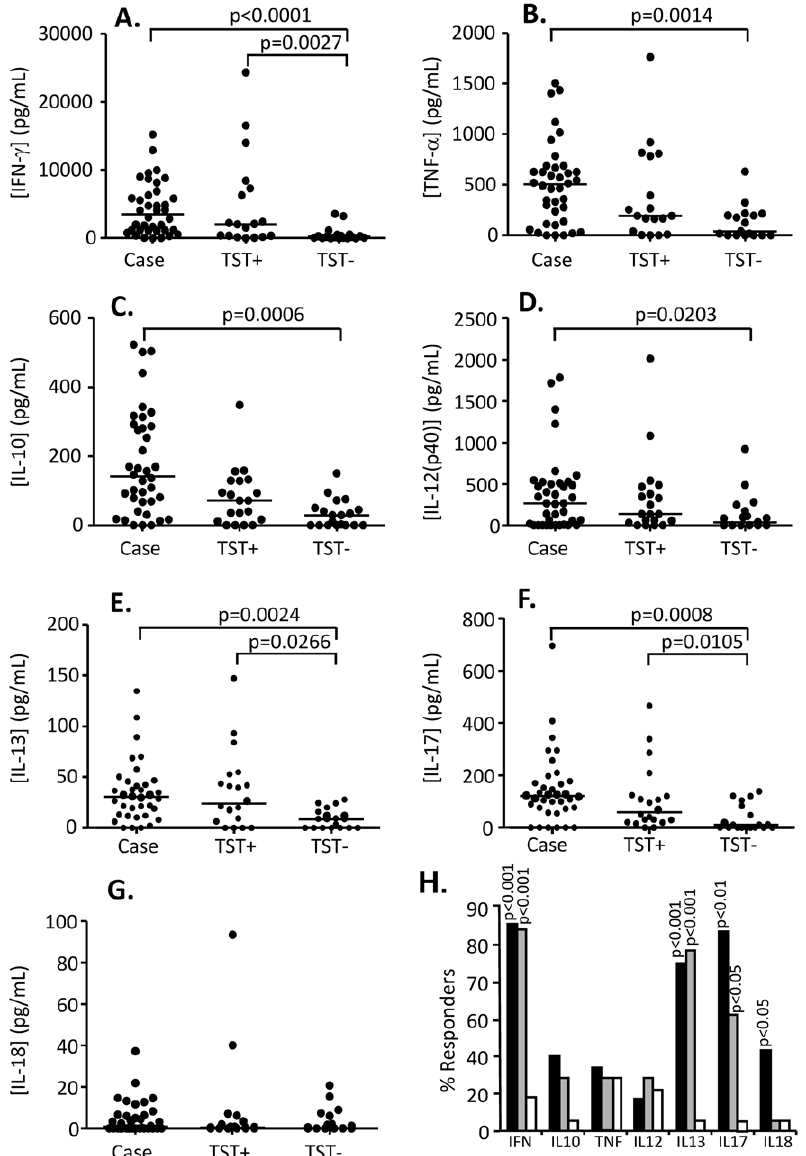
Figure 1. Cytokine responses following PPD stimulation. Whole blood from TB cases (n=36), TST + (n=20) and TST 2 (n=19) contacts was stimulated for 7 days with PPD and the supernatant assessed by multiplex cytokine analysis. A) IFN- c . B) TNF- a , C) IL-10, D) IL-12(p40), E) IL-13, F) IL-17 and G) IL-18. Line indicates median. Data were analysed using Tweedie distributions with p-values indicating significant differences after adjustment for age and sex. H) Percentage of responders producing IFN- c , IL-10, TNF- a , IL-12, IL-13, IL-17, IL-18. Dark bars=cases, grey bars=TST + contacts, white bars=TST 2 contacts; p-values are indicated and refer to comparison with TST 2 contacts.